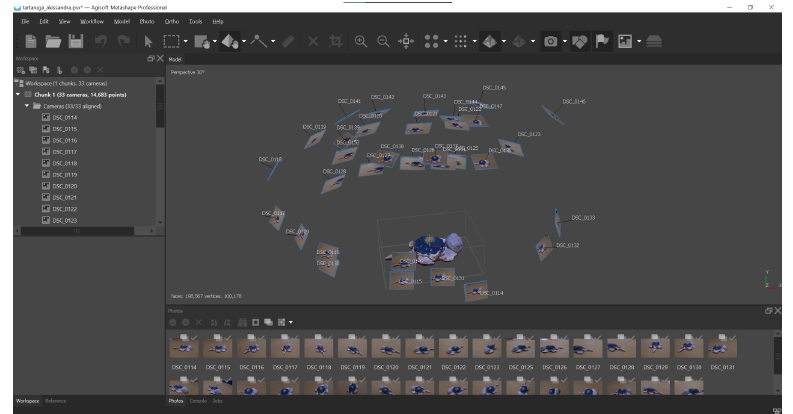
Figure 2. Camera alignment process in Agisoft Metashape.